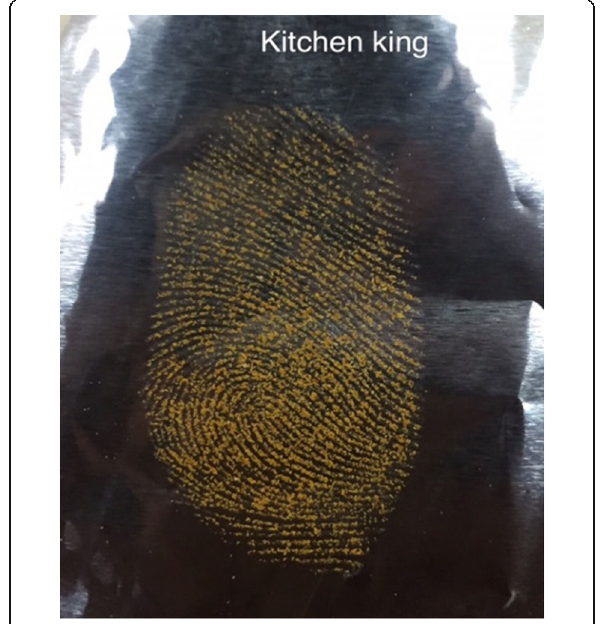
Fig. 15 Development of Latent fingerprint by Kitchen King Powder on Aluminum Foil